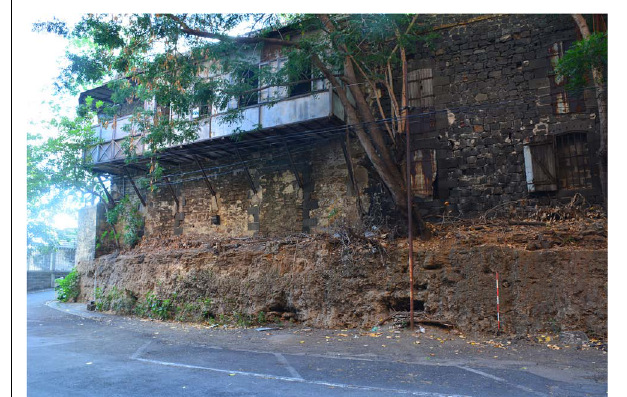
FIGURE 2 | Fossil reef located in Port Louis, used during the colonial period as foundations for a hospital block attached to the immigration depot. This type of formation evidences the fringing reef that would have characterized the island as it formed during successive volcanic